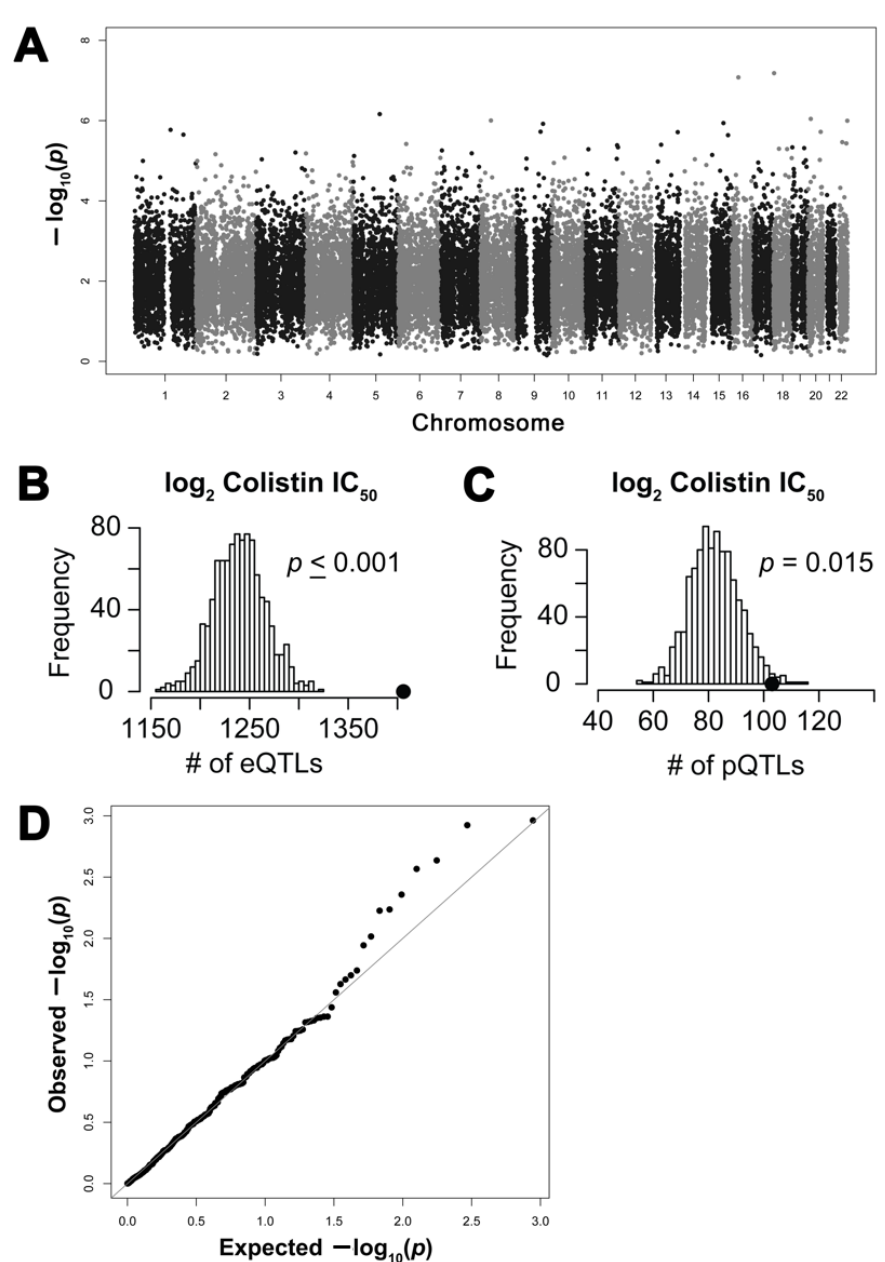
Figure 2. Genetic association studies: ( A ) Manhattan plot of association between SNPs and colistin half maximal inhibitory concentration (IC 50 ). At p ≤ 0.001 3 , 12,948 SNPs (2,711 after Linkage Disequilibrium correction) were associated with cytotoxicity. The top SNP was located on chromosome 18, associated at p = 6.49 × 10 − 8 . ( B ) Global enrichment analysis of the distribution of expression quantitative trait locus (eQTL) counts in 1000 simulations, each matching the Minor Allele Frequency distribution of all colistin-associated SNPs at p ≤ 0.001 (after LD correction). The black dot (●) represents the observed eQTL count ( n = 1402 eQTLs at p ≤ 0.0001) in the colistin susceptibility-associated SNPs. Colistin-associated SNPs are enriched for eQTLs ( p ≤ 0.001 ). ( C ) The pQTL enrichment analysis of the 441 proteins quantified by microwestern and reverse phase protein arrays. Colistin-associated SNPs at p ≤ 0.001 are enriched for mRNA-independent protein quantitative trait loci (pQTLs) among these ( n = 271 pQTLs at p ≤ 0.0001). The black dot ( ) represents the observed pQTL count ( n = 104) in the colistin susceptibility-associated SNPs ( p = 0.015). ( D ) Quantile – quantile (Q–Q) plot representing the observed associations between baseline protein expression and colistin IC 50 . At p ≤ 0.05, 23 proteins were significantly associated. Solid line indicates a false discovery rate (FDR) of